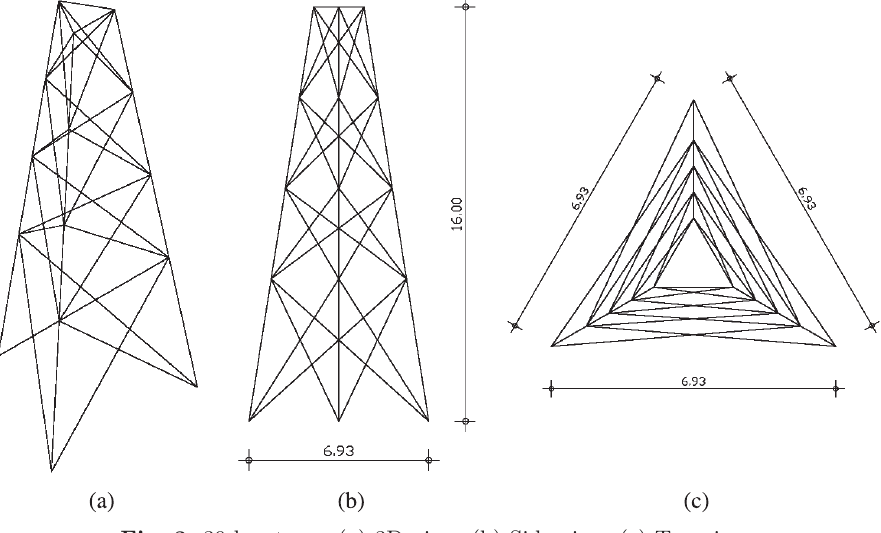
Fig. 3. 39-bar truss: (a) 3D view, (b) Side view, (c) Top view. Table 1. 39-bar truss example: characteristics of the random